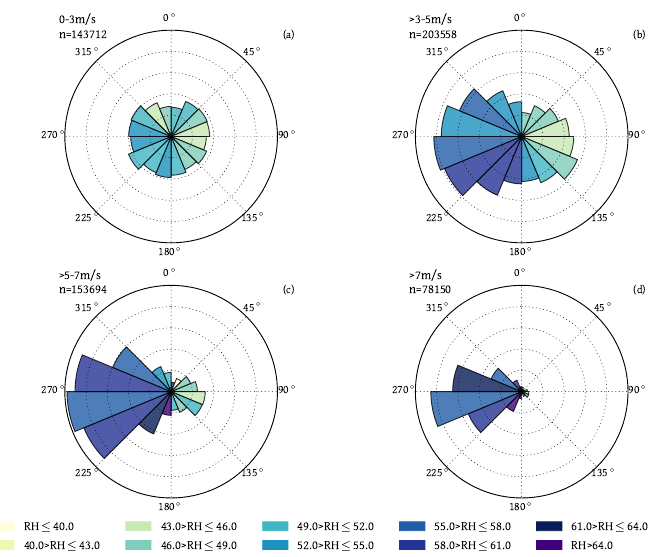
Figure 9. Relationship between RH [%], wind direction and speed. Setup of figures ( a – d ) is identical to previous plot.